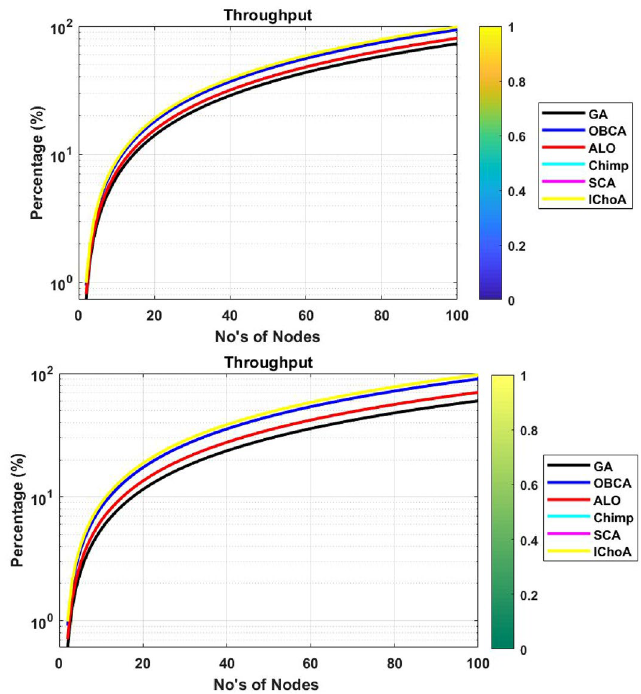
Figure 9. Throughput graphs of metaheuristics on functions F 2 and F 6 .